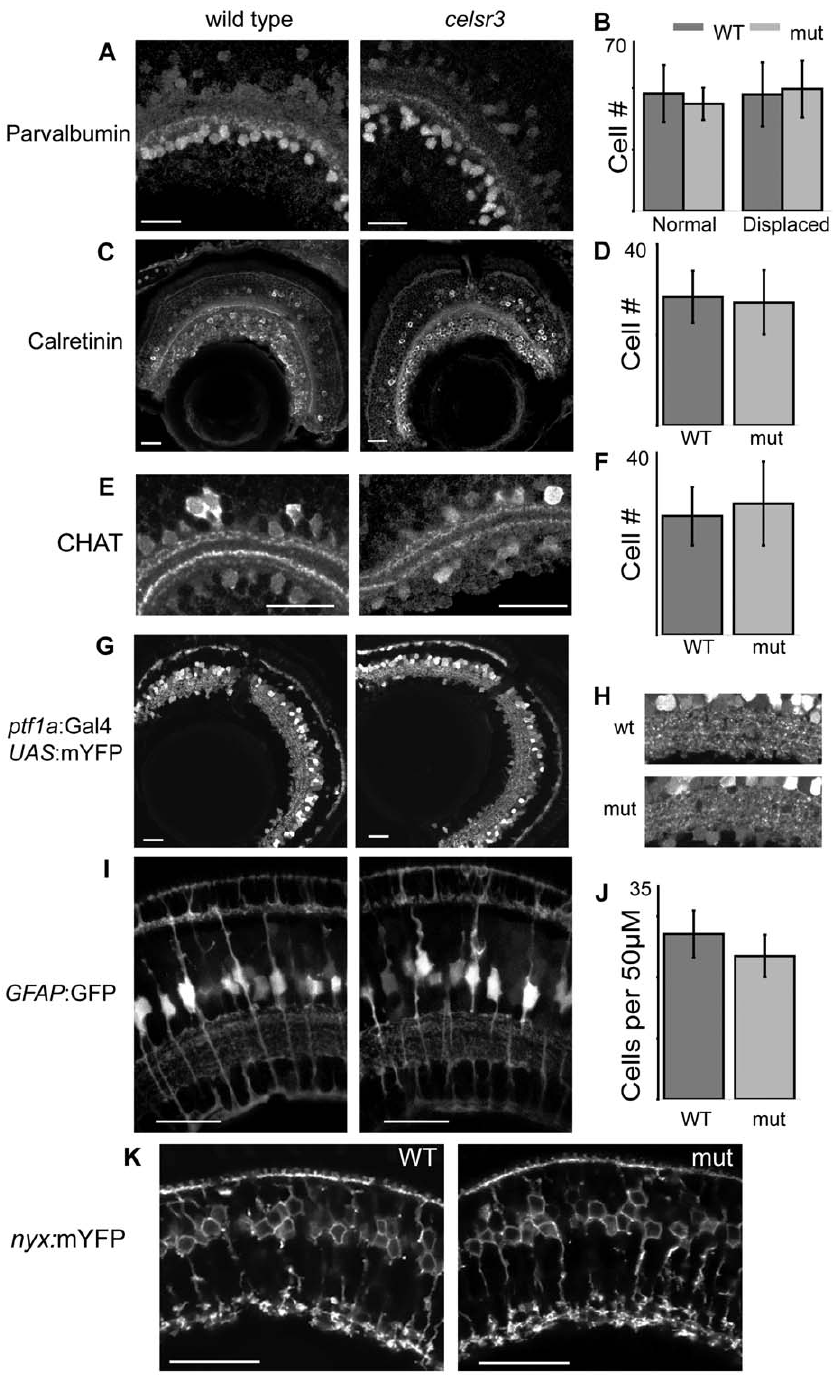
Figure 5. Cell localization and IPL organization are unchanged in the celsr3 mutant. A) a -parvalbumin labels all displaced amacrine cells and a subpopulation of amacrines in the INL. B) counts of parvalbumin cells, displaced and normal amacrines were counted separately C) a -calretinin labels a subpopulation of amacrines in the INL and all ganglion cells. D) Counts of calretinin positive amacrine cells. E) a -CHAT stains a subpopulation of amacrine cells that laminate in 2 major and 2 minor sublaminae within the IPL. All sublaminae are present in the mutant. F) counts of CHAT positive amacrine cells in the INL G) Tg( ptf1a: Gal4VP16, UAS: mYFP) animals express mYFP in all amacrine and horizontal cells. H) Close ups of the IPL in Tg( ptf1a: Gal4VP16, UAS: mYFP) animals I) Images of Tg( GFAP:GFP ) animals, which express GFP in all Mu¨ller cells. J) Counts of Mu¨ller cells per 50 m M. K) Tg( nyx: mYFP) animals express mYFP in the ON-bipolar cells. Scale bars are 20 m m. doi:10.1371/journal.pgen.1002239.g005 kainate receptor antagonist 6,7-dinitroquinoxaline-2,3-dione amacrine, horizontal and ganglion cells. Thus, in DNQX, (DNQX), which blocks both the interaction of the OFF-bipolar remaining transmission is from photoreceptors to ON-bipolar cells with the photoreceptors and the majority of the input to cells. Using DNQX, we found that the ON-bipolar b-wave